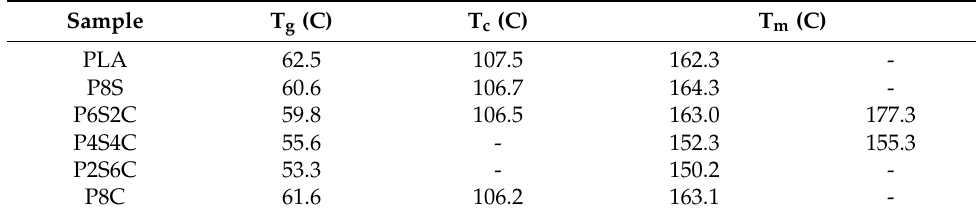
Figure 7. DSC analysis of the neat PLA and biocomposites. Table 4. DSC analysis data value.